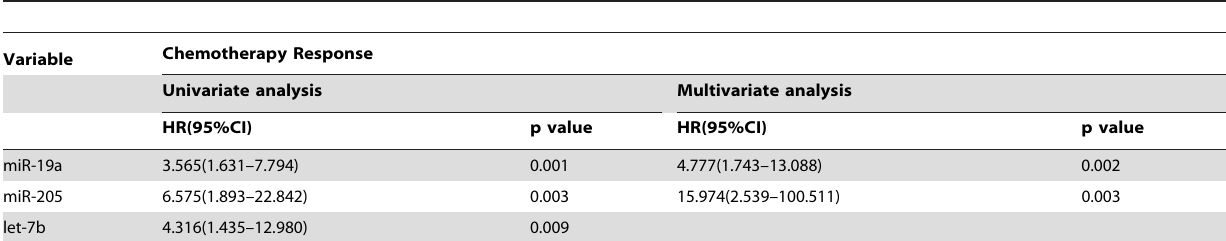
Table 4. Univariate and Multivariate Cox proportional hazards regression analysis of miRNAs in relation to chemotherapy